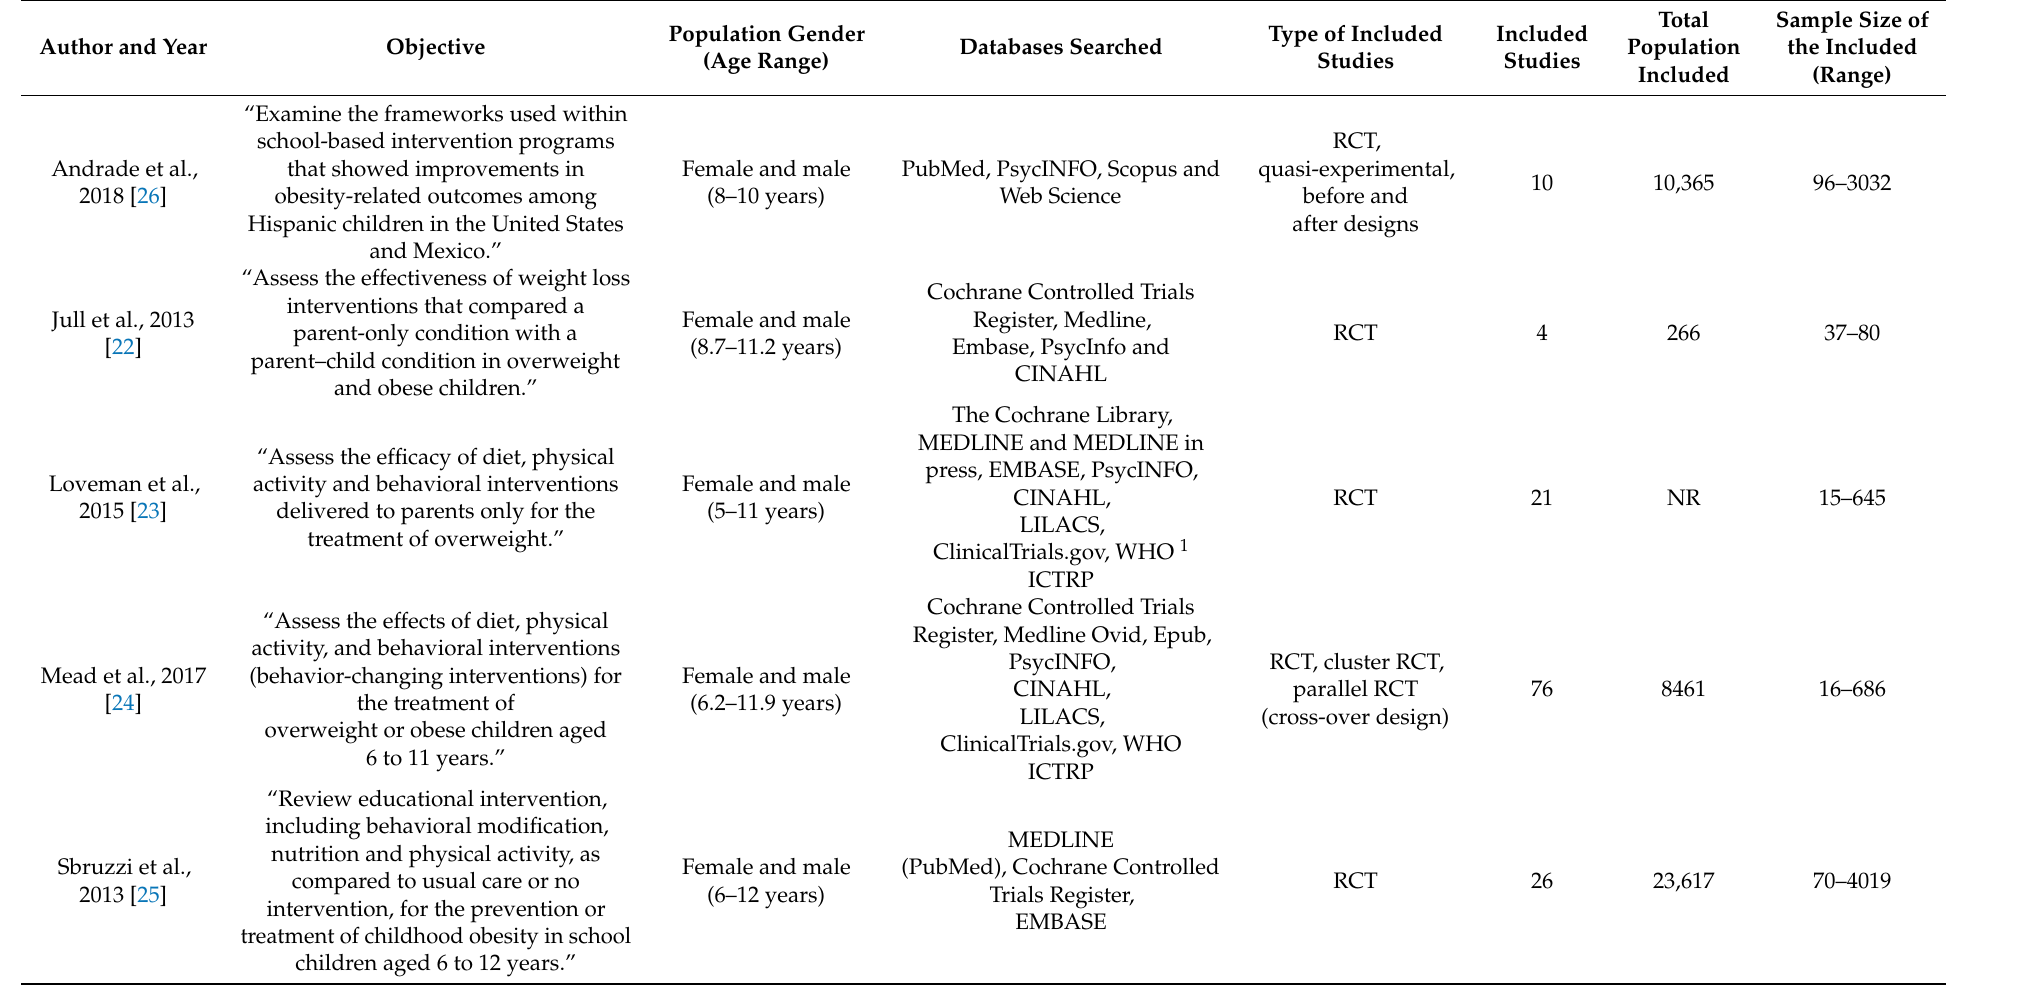
Table 1. Characteristics of the included systematic